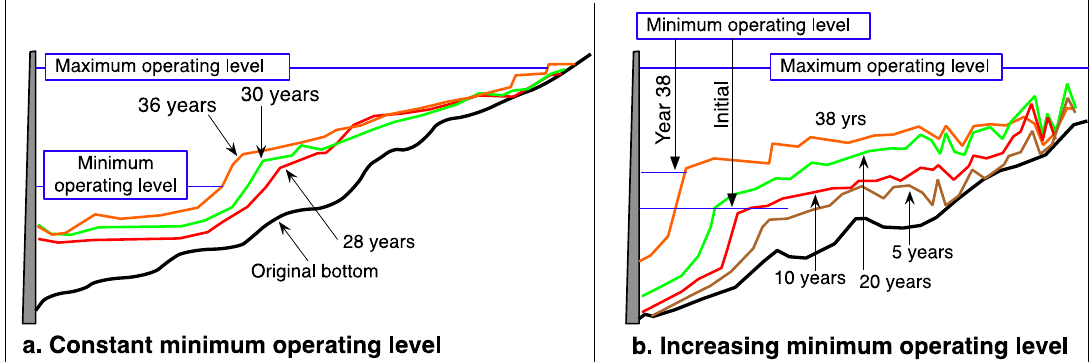
Figure 13. ( a ) Advance of reservoir delta with constant minimum operating level, La Esmeralda reservoir, Colombia. ( b ) By increasing the minimum operating level, sediment deposits are focused onto the top of the delta rather than on the forward face, Tarbela reservoir, Pakistan.